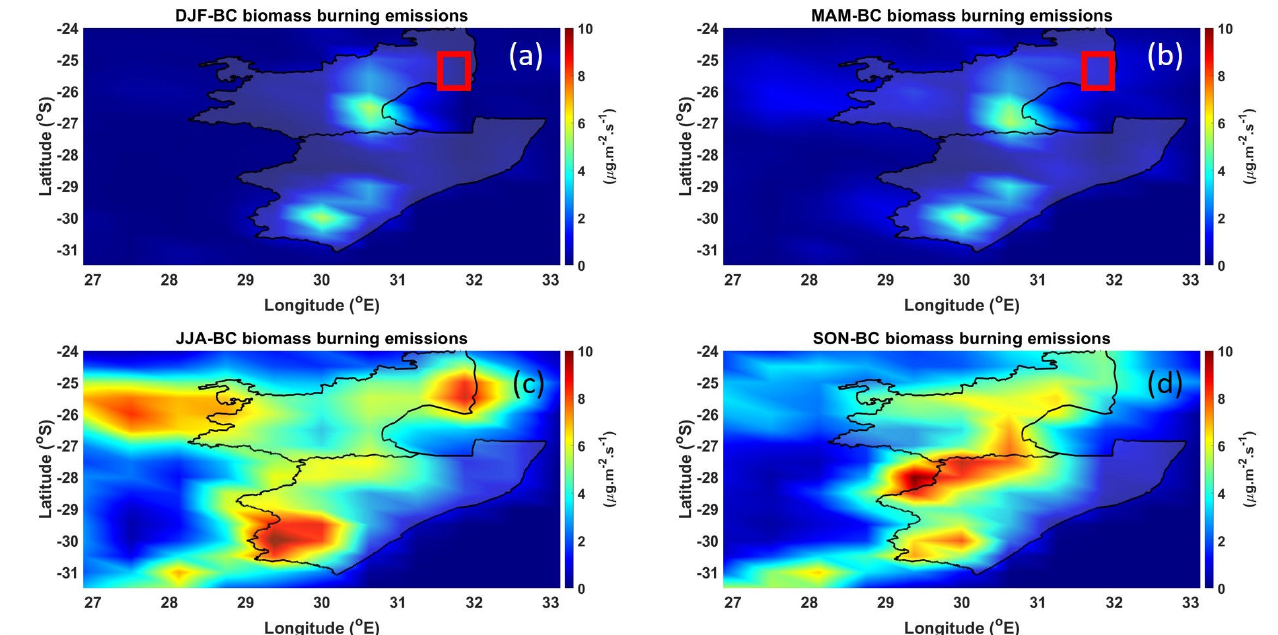
Figure 3. BC biomass emissions over the MP and KZN regions during the ( a ) DJF, ( b ) MAM, ( c ) JJA, and ( d ) SON seasons.